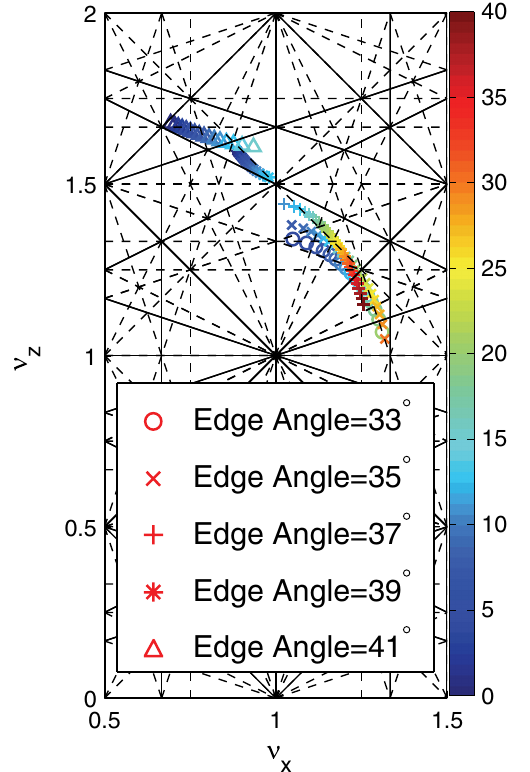
FIG. 2. Tune diagram for various edge angles of dipole magnets and quadrupole focusing strengths in units of m − 2 . Four 90° dipole magnets of length 0.40 m each, and two 10-cm quadru- poles located at the centers of the long straight sections are included in the calculation. Different types of markers stand for edge angles of dipole magnets. The color bar indicates focusing strengths of the quadrupoles.